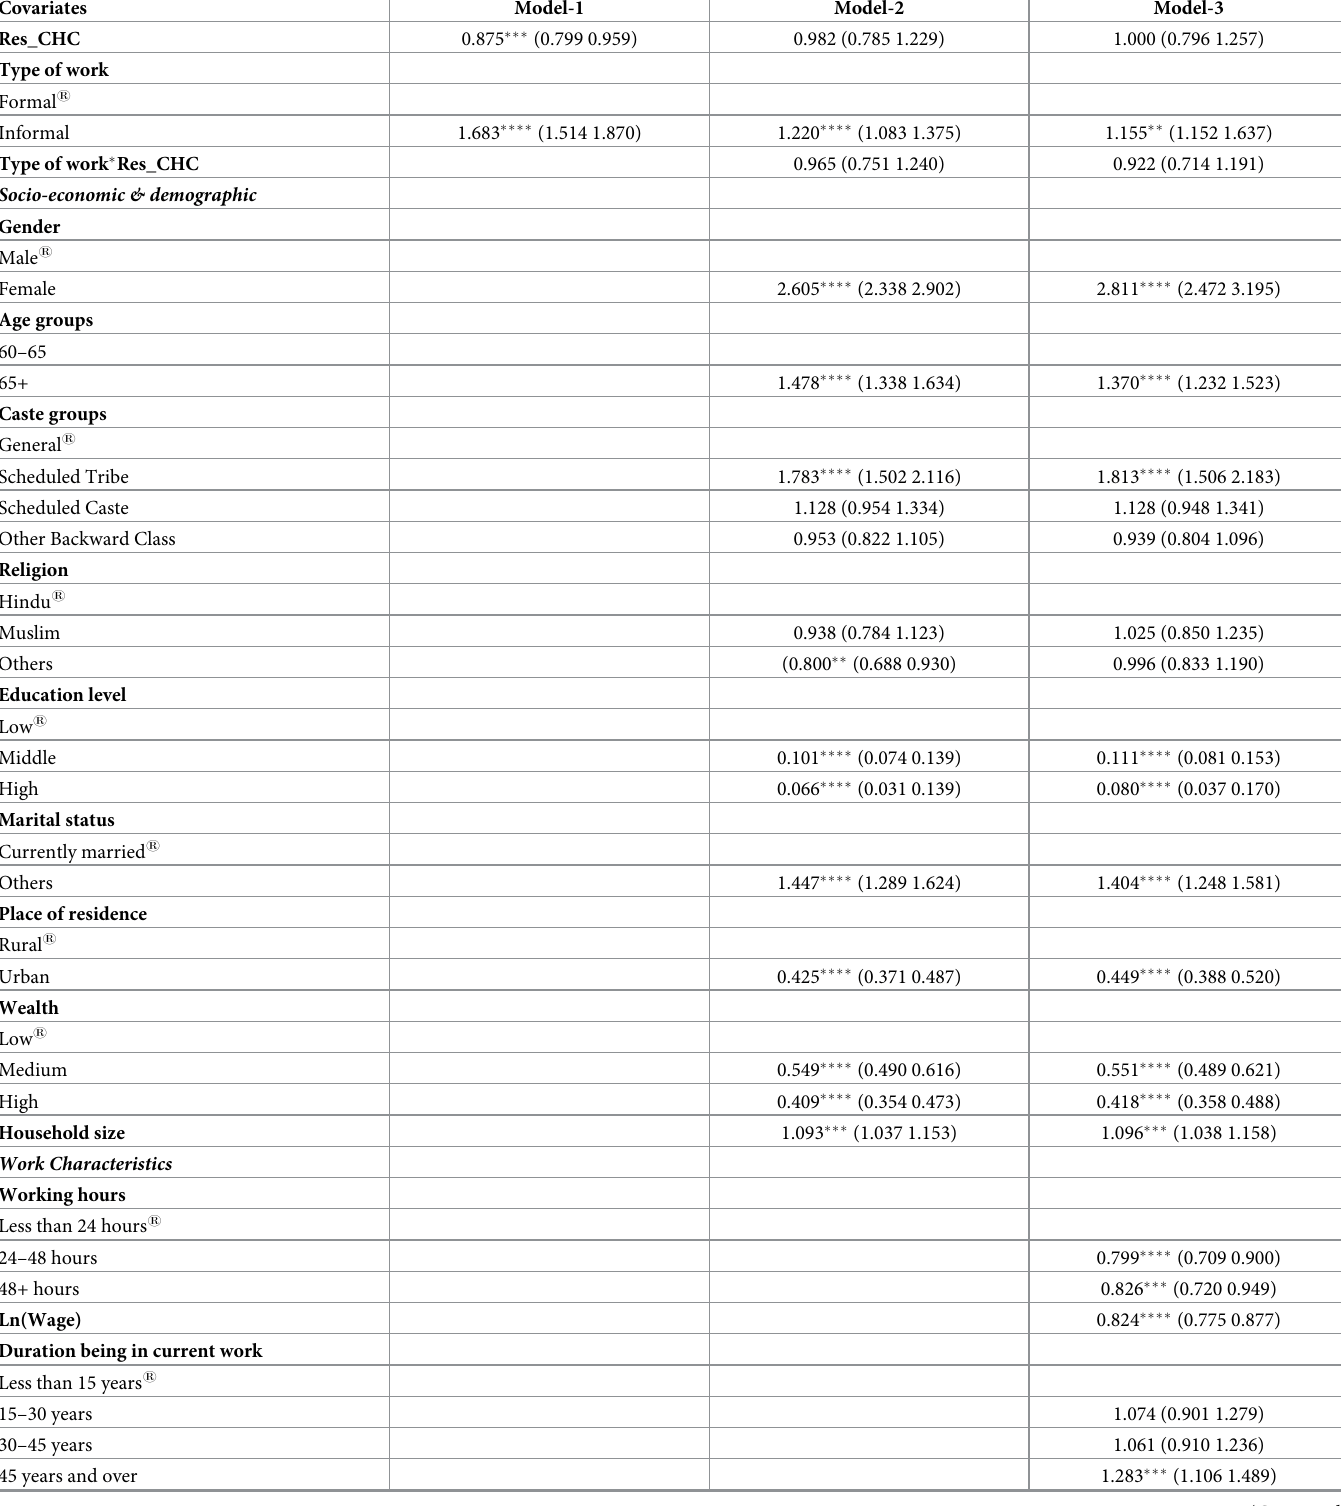
Table 6. Odds of multiple logistic regression for